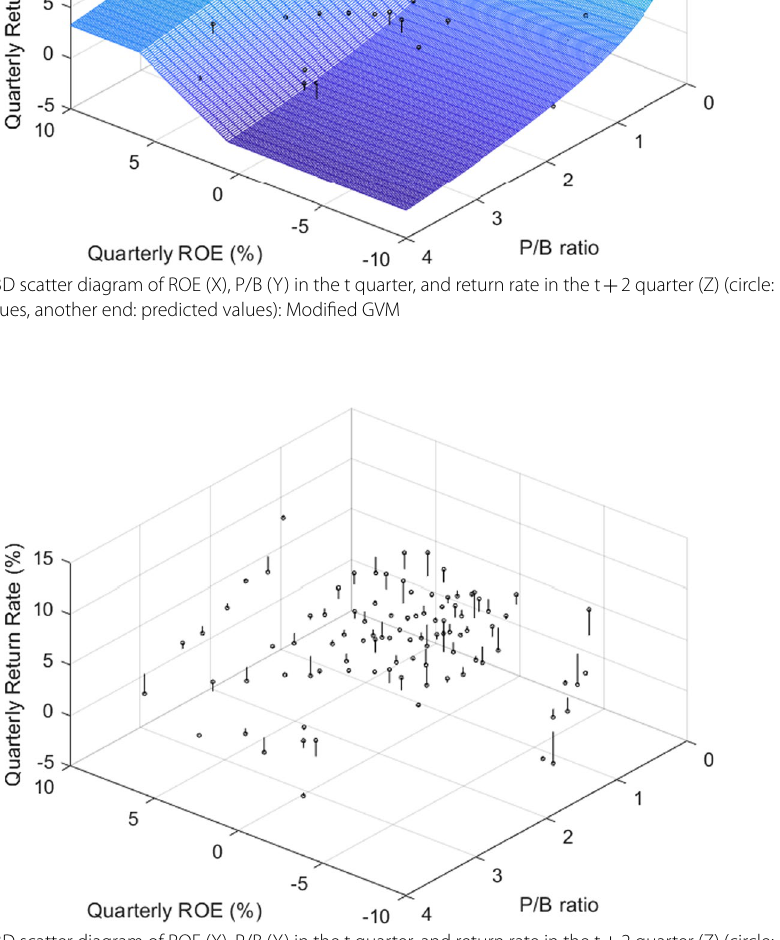
2 quarter (Z) (circle: +